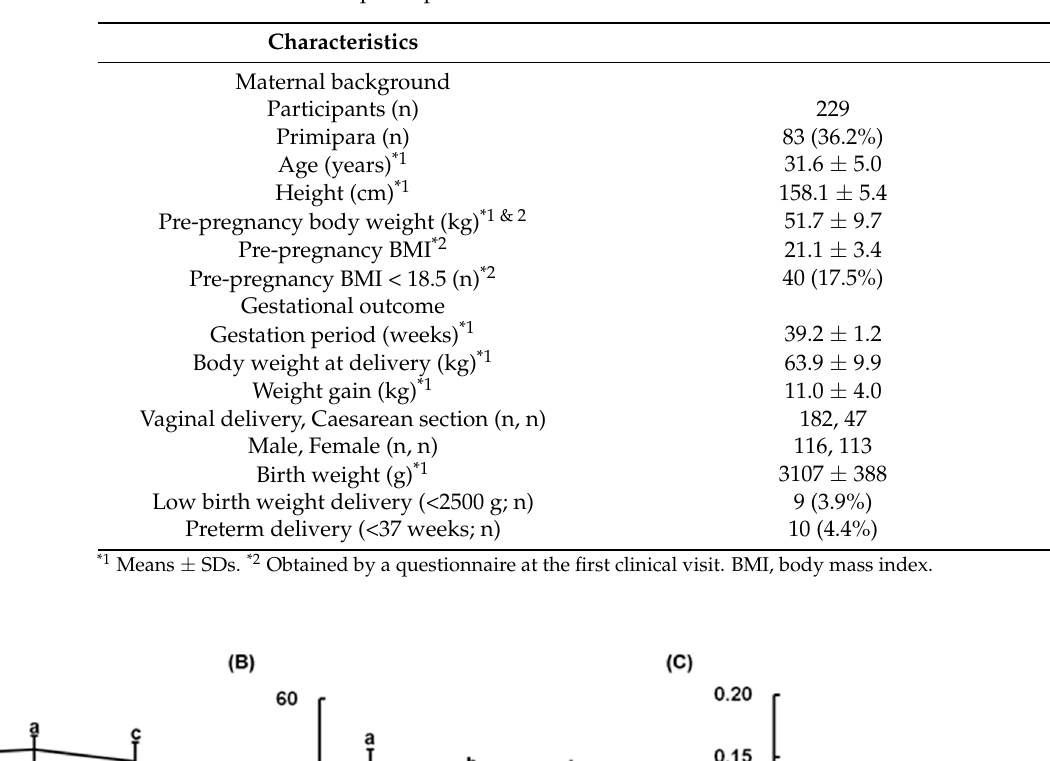
5 of 13 Table 1. Characteristics of participants. Characteristics Maternal background Participants (n)